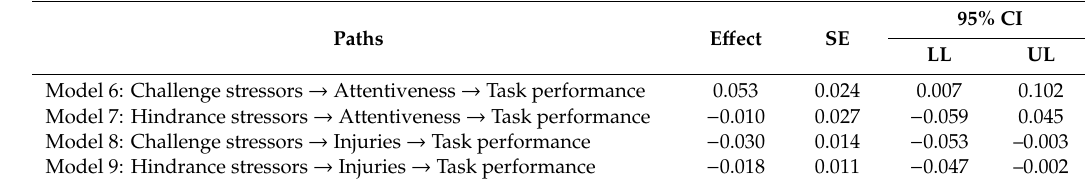
Table 4. Results of the mediation testing using PROCESS (Bootstrap = 5000). Paths Model 6: Challenge stressors → Attentiveness → Task performance Model 7: Hindrance stressors → Attentiveness → Task performance Model 8: Challenge stressors → Injuries → Task performance Model 9: Hindrance stressors → Injuries → Task